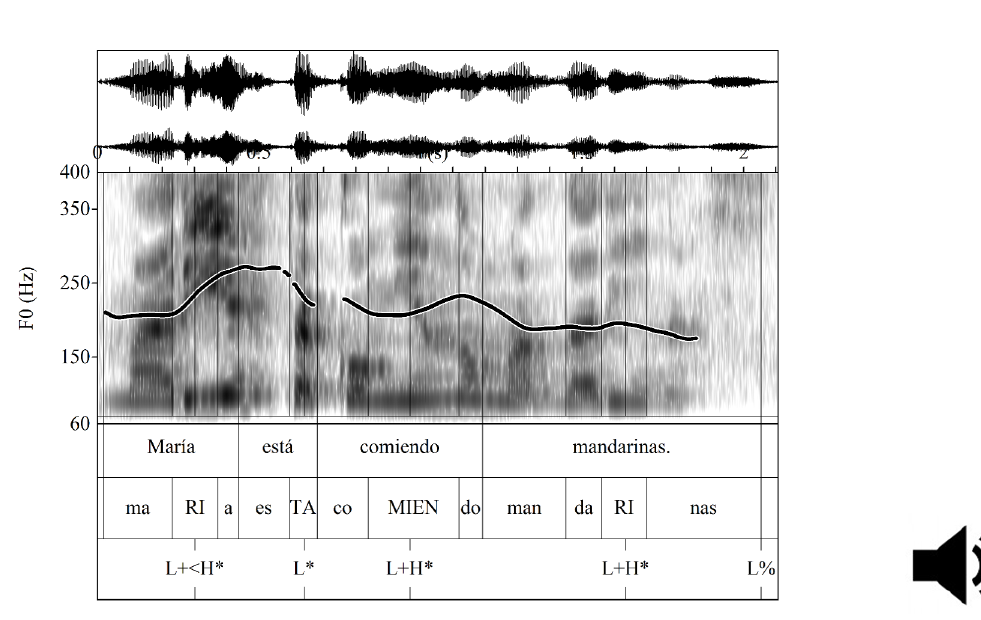
Figure 1 (Participant 3): Waveform and F0 trace for the broad focus statement Maria está comiendo mandarinas ‘Mary is eating tangerines’ produced with L+<H*, L* and L+H* pre-nuclear accents and an L+H* nuclear accent followed by an L% boundary